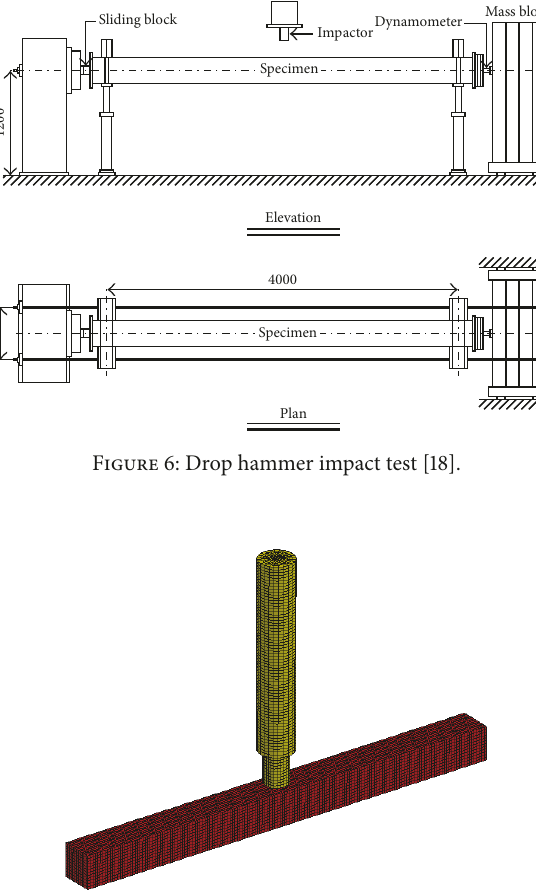
Figure 7: Numerical model of drop hammer impact